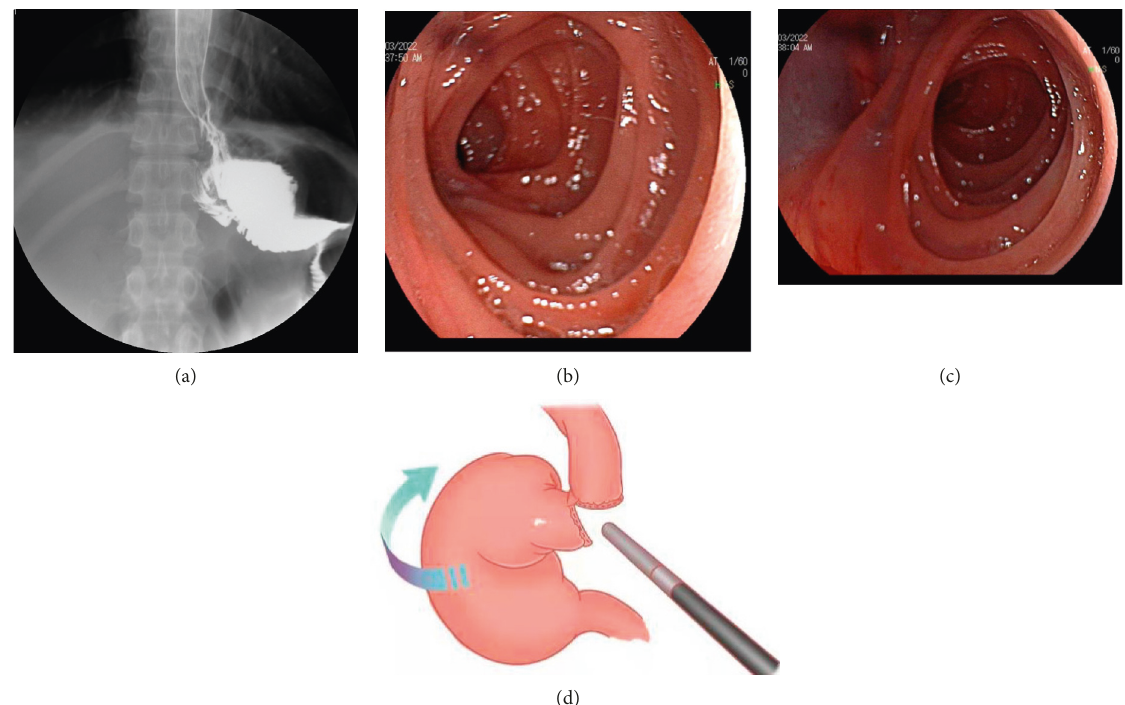
Figure 6: (a) Angiography on day five after surgery showing no anastomotic leakage. (b) Electronic gastroscopy 6 months after surgery showing no anastomotic stenosis. (c) Inside the dotted circle is the upper margin requiring a pathological